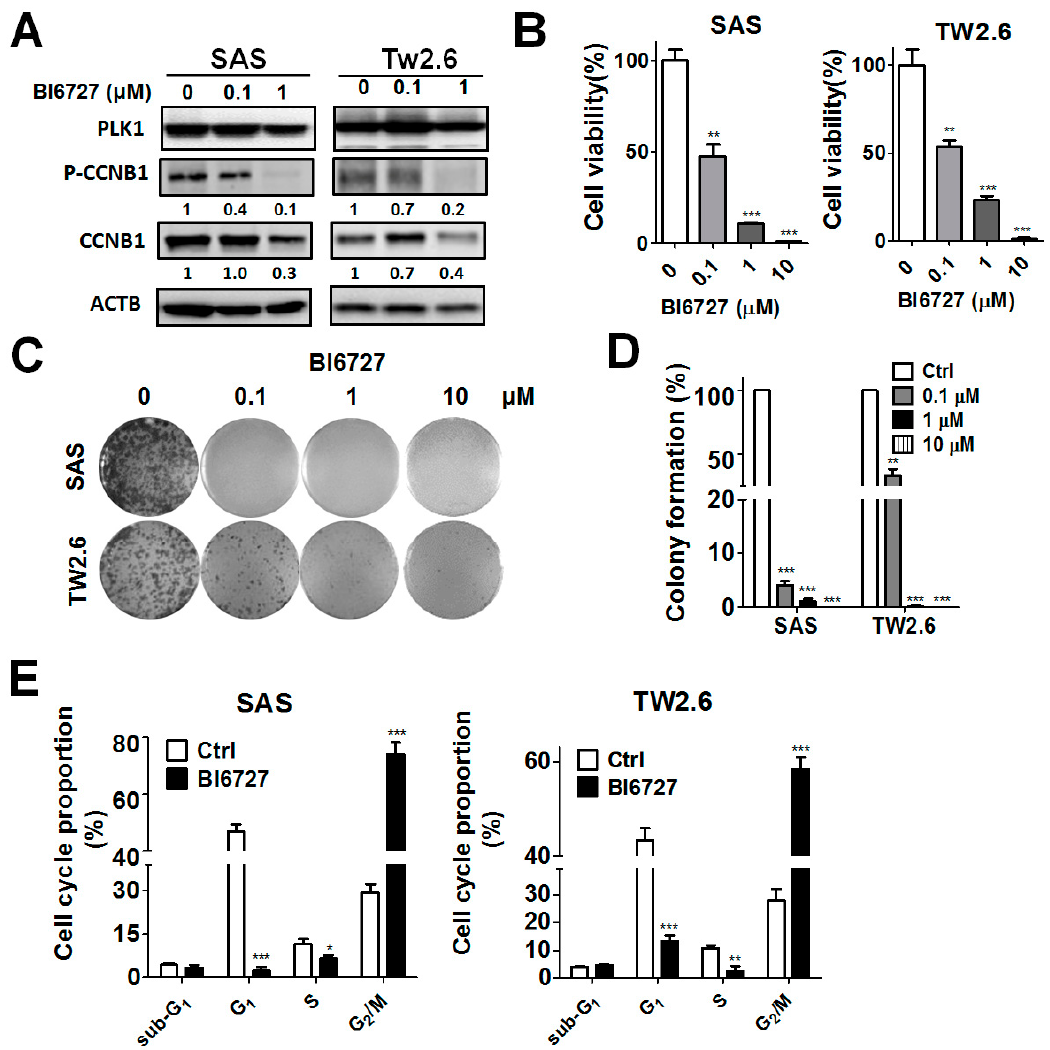
Figure 4. Effects of the PLK1 (polo-like kinase 1) inhibitor on the proliferation of OSCC (oral squamous cell carcinoma) cells. ( A ) Human oral cancer SAS and TW2.6 cells were treated with the PLK1 inhibitor BI6727 for 24 h and harvested for immunoblotting to measure the protein level of PLK1, CCNB1 (cyclin B1), and phosphorylated CCNB1. ( B ) The proliferation of treated cells